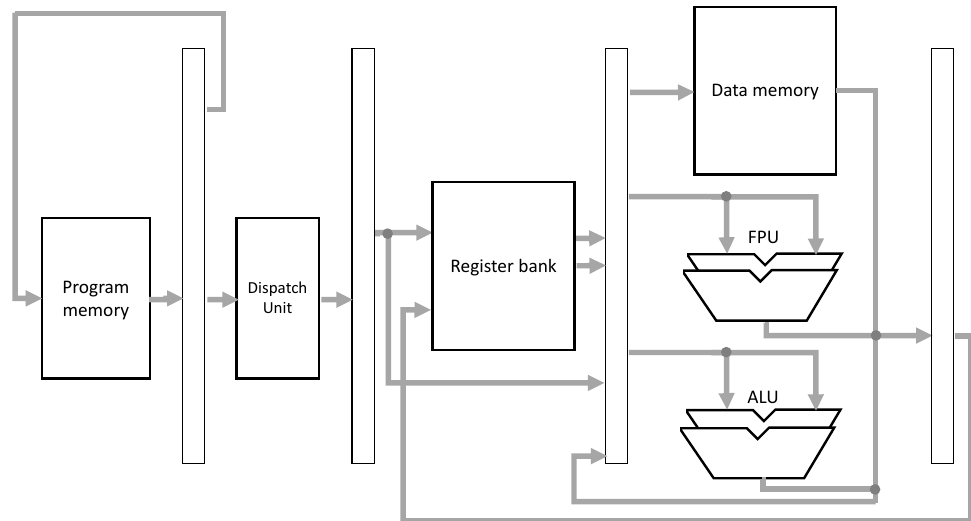
Figure 14. Simplified view of the superscalar architecture of